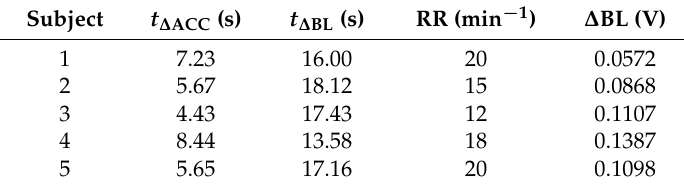
Table 5. Main parameters of body variation from a standing position to a sitting position. Subject